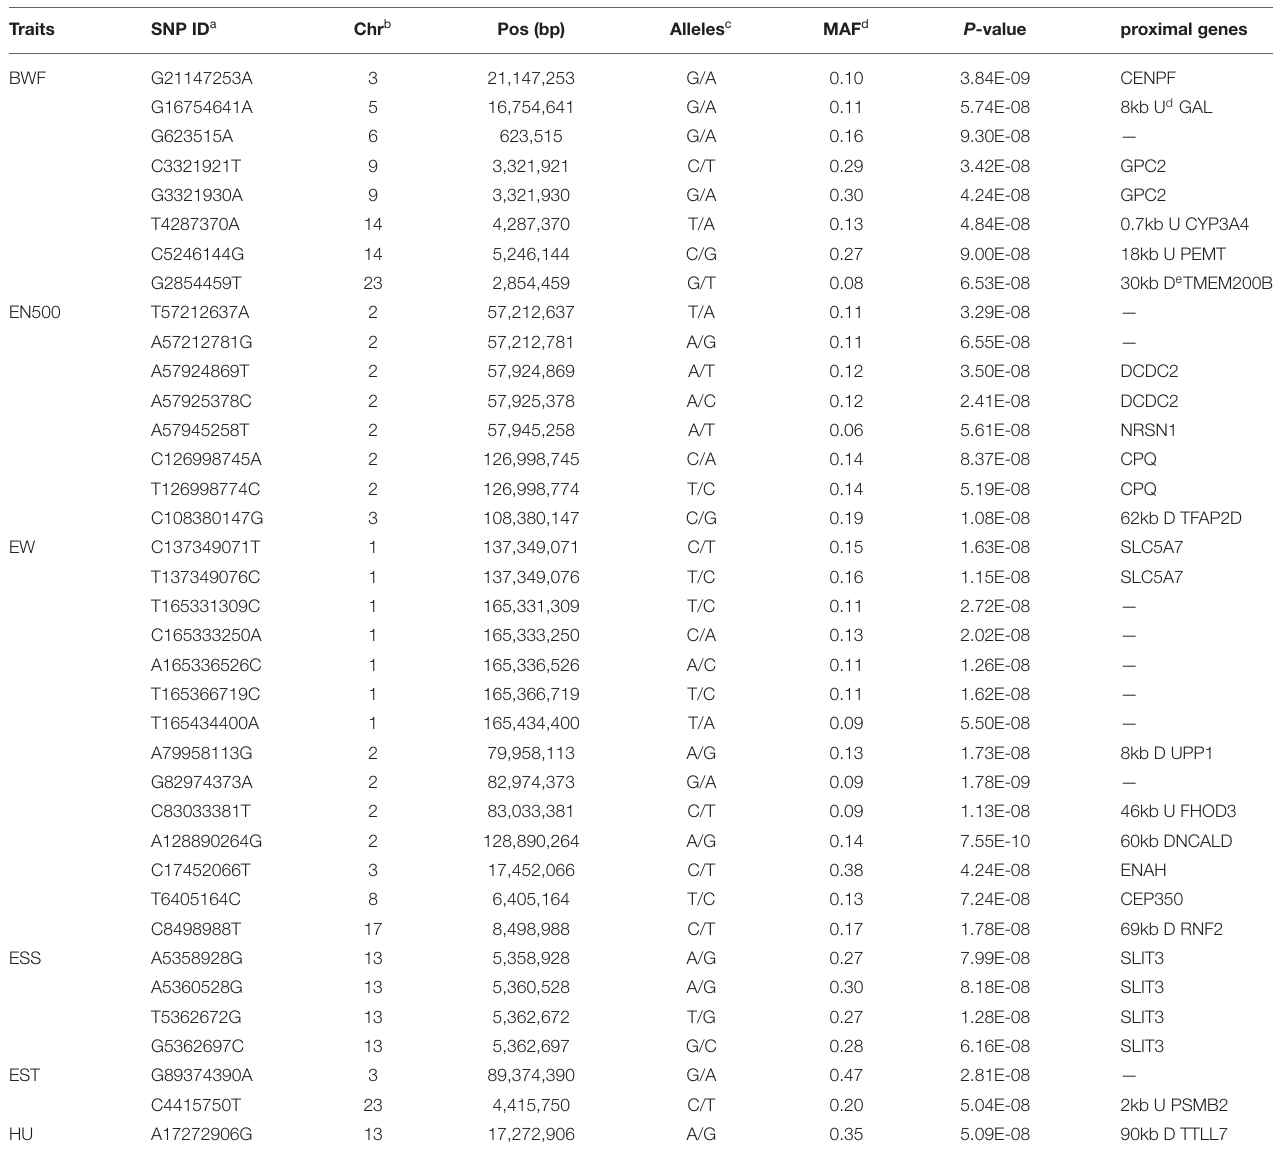
TABLE 3 | Statistics for significant SNPs and proximal genes.